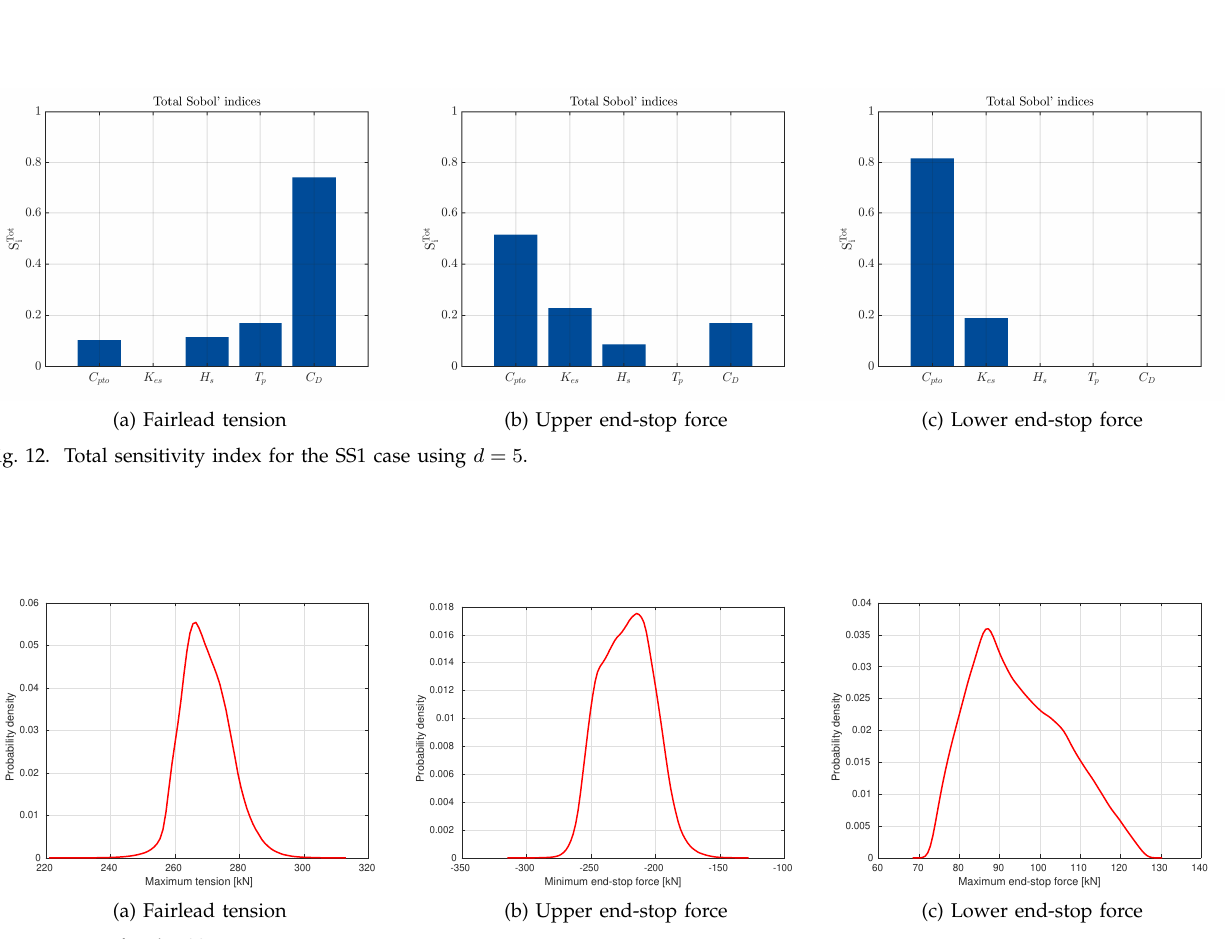
Fig. 13. PDFs for the SS2 case using d = 5 .